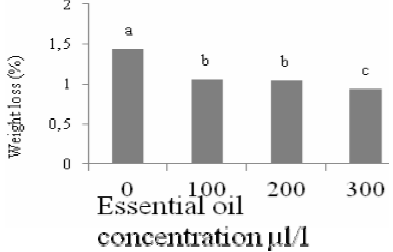
Fig. 3. The effect of basil essential oil treatment on TSS/TA of ‘Golden Drop’